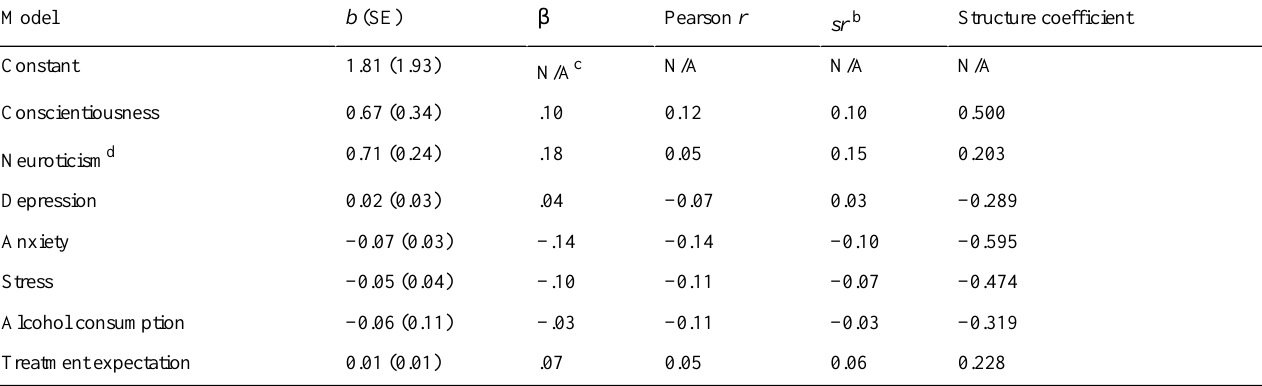
Table 3. Standard regression results for personality, negative affect, and treatment expectations predicting engagement with web-based self-assessments (n=390) a .